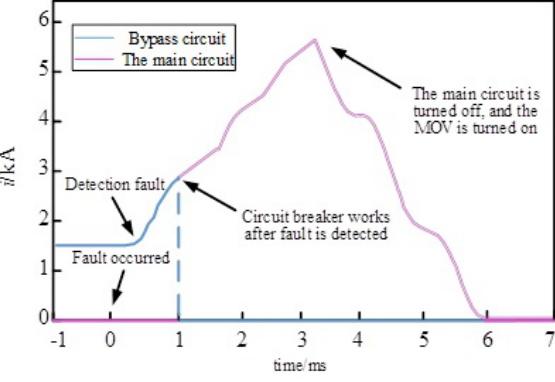
Fig. 12. Single-pole mid-end ground fault simulation results when faults of different transition resistance occur.